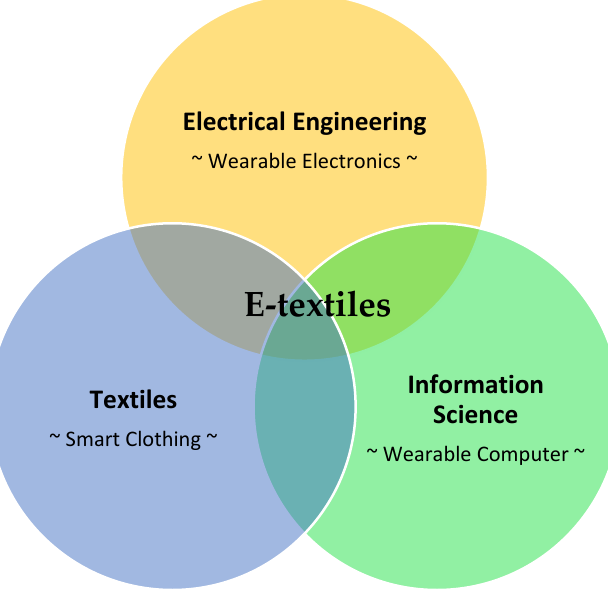
Figure 1. Area of textiles embedded with electronic devices.